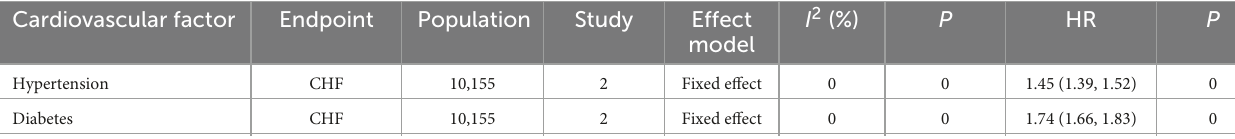
TABLE 3 Hazards ratio of cardiovascular risk factor for anthracycline-induced cardiotoxicity. Cardiovascular factor Endpoint Population